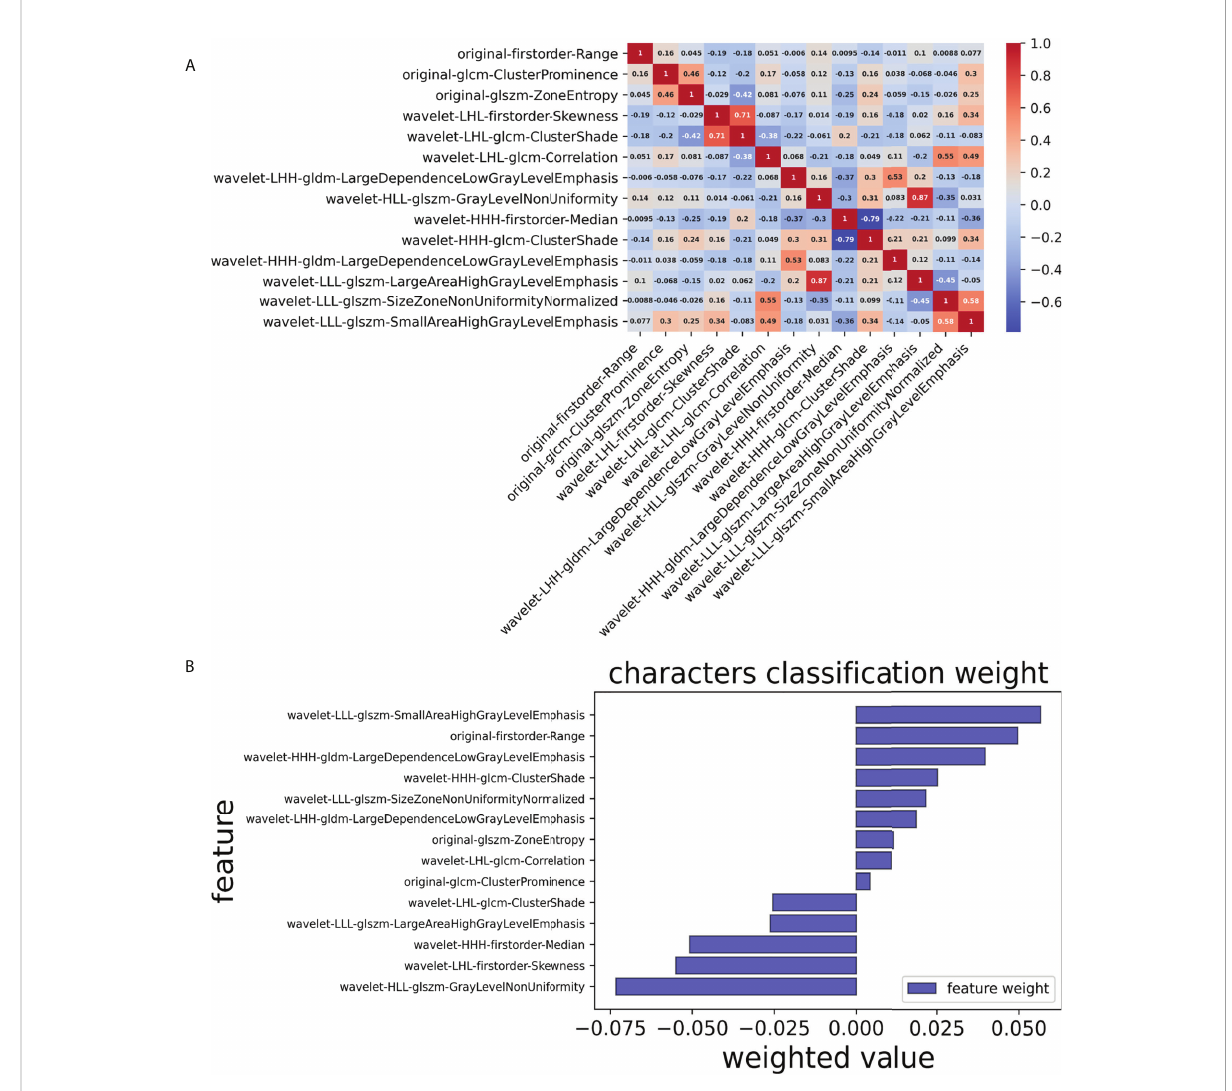
FIGURE 3 Selection of signi fi cant parameters in features in the training set and de fi nition of the linear predictor. (A) Spearman ’ s correlation coef fi cients were calculated for the fourteen selected features. (B) Characters classi fi cation weight of the